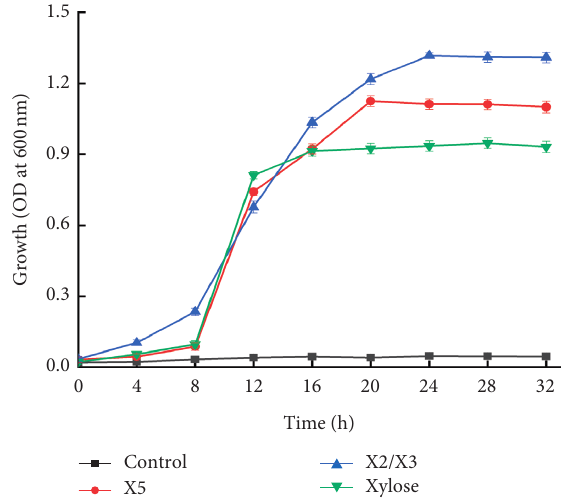
Figure 1: Growth of B . adolescentis on different polymerized XOS and control medium (no